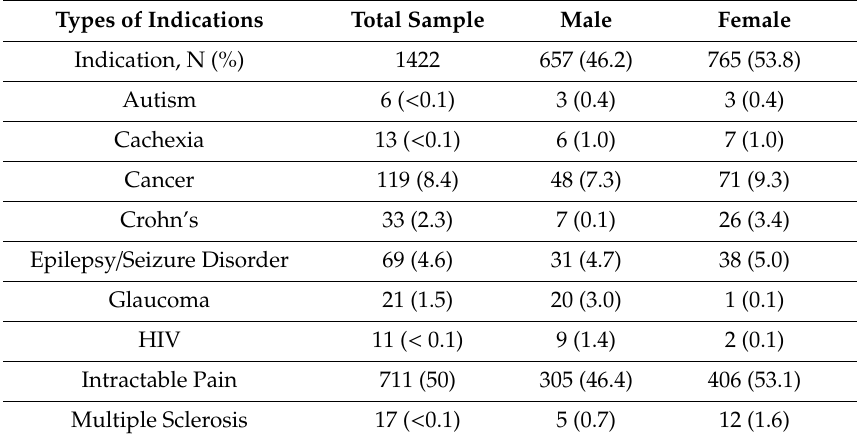
Table 4. Comparison of indications used for MM recommendations in male and female patients in Louisiana MM